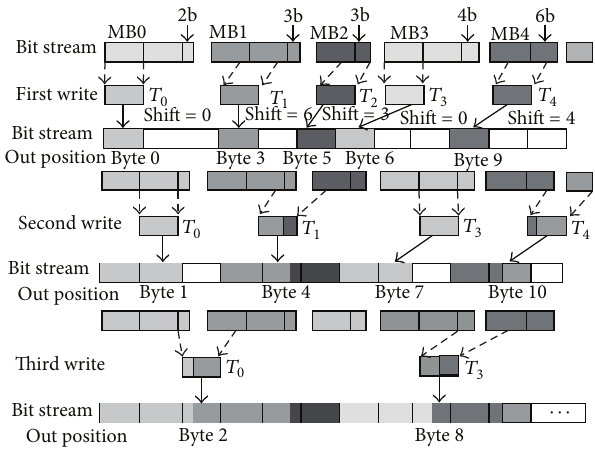
Figure 10: Calculation of start position for each MB.